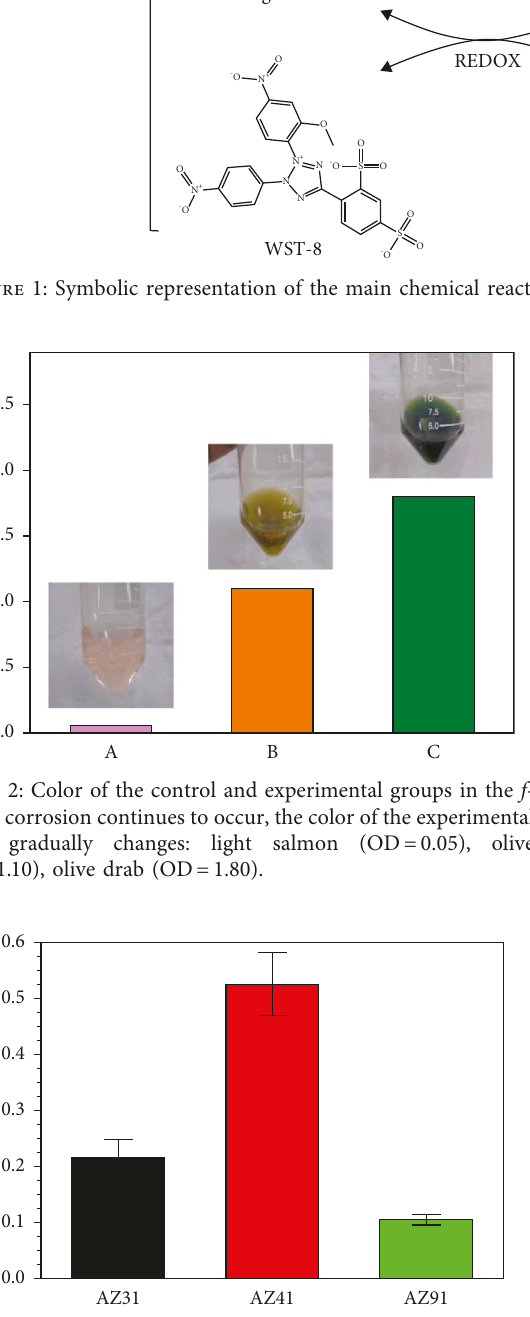
Figure 3: The weight change of the tested specimens after a one- week immersion experiment (the red, green, and black bars rep- resent three alloys,